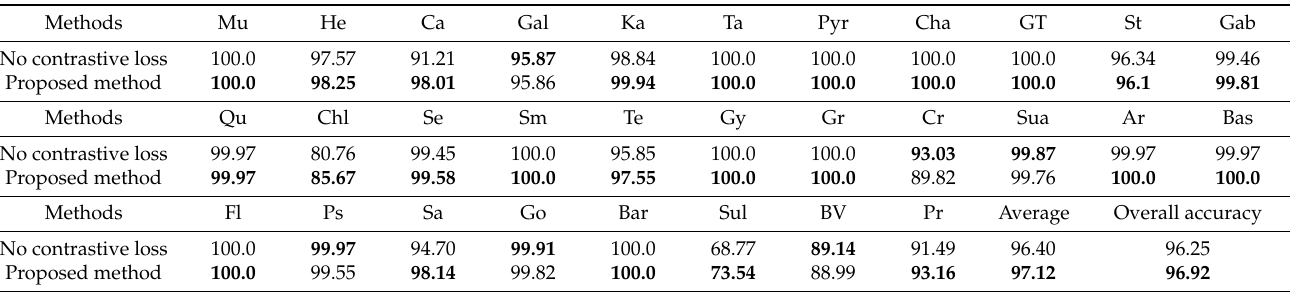
Table 5. Effect of category-aware contrastive loss on classification results in F 1 − score per class (%). For abbreviation, muscovite (Mu), hematite (He), calcite (Ca), galena (Gal), kaolinite (Ka), talcum (Ta), pyrite (Pyr), chalcopyrite (Cha), gray tiemannite (GT), stibnite (St), gabbro (Gab), quartz (Qu), chlorite (Chl), serpentine (Se), smaltite (Sm), tennantite (Te), gypsum (Gy), graphite (Gr), crystal (Cr), suanite (Sua), aragonite (Ar), basalt (Bas), fluorite (Fl), psilomelane (Ps), saponite (Sa), goethite (Go),